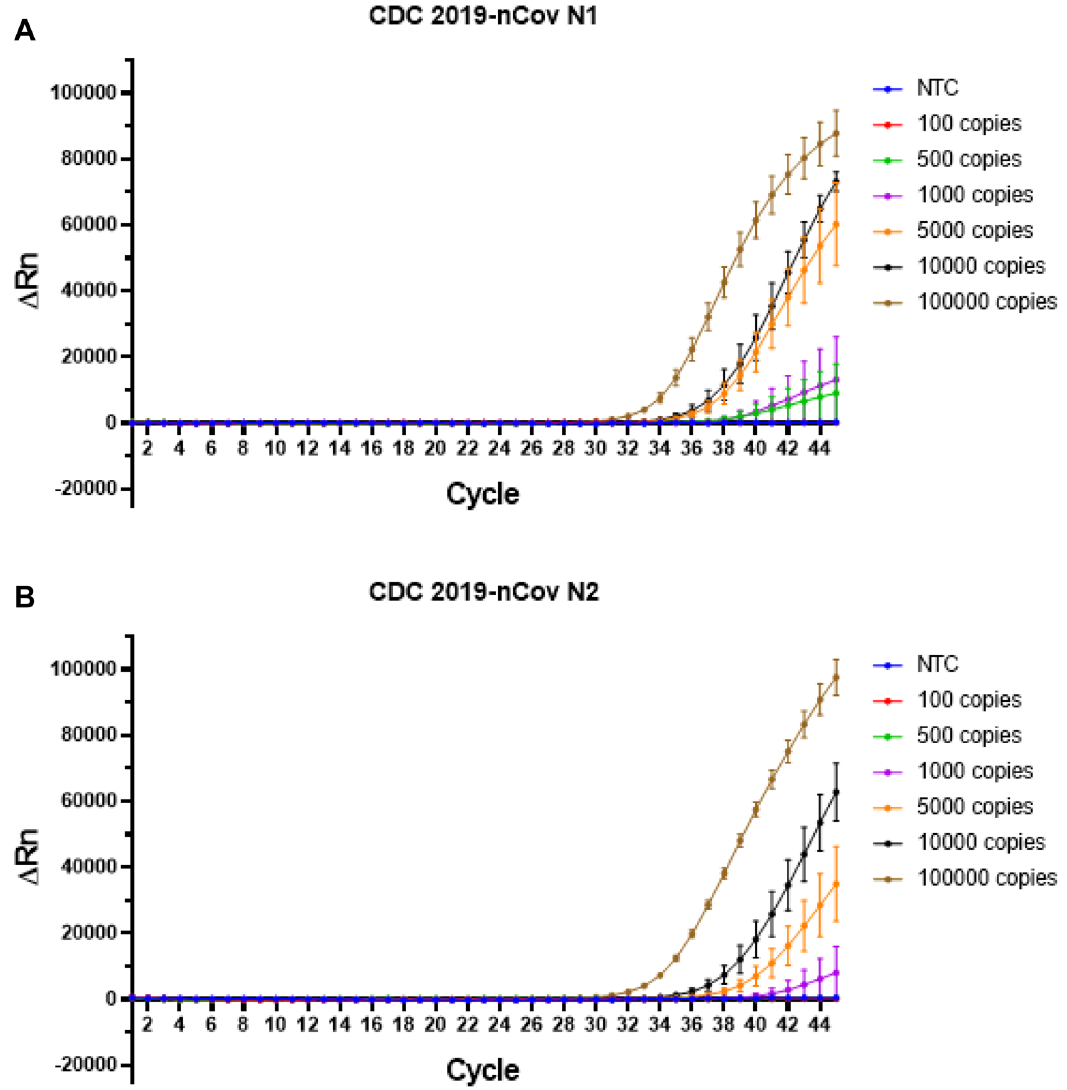
Figure 6. Detection limit of RT-qPCR assay using the CDC real-time RT-PCR diagnostic panel. Real-time measurement of SARS-CoV-2 RNA using the ( A ) 2019-nCov N1 assay and ( B ) 2019-nCov N2 assay was recorded as normalised fluorescent signals (ΔRn) along 45 cycles. Pooled results are displayed as means of six biological and technical repeats, error bars represent